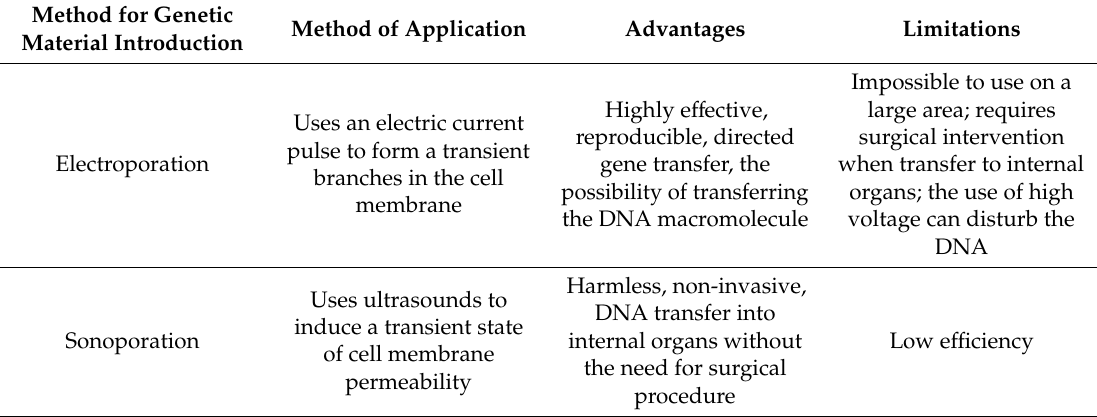
Table 2. Electroporation and sonoporation as non-viral methods of transfer of genetic material in gene